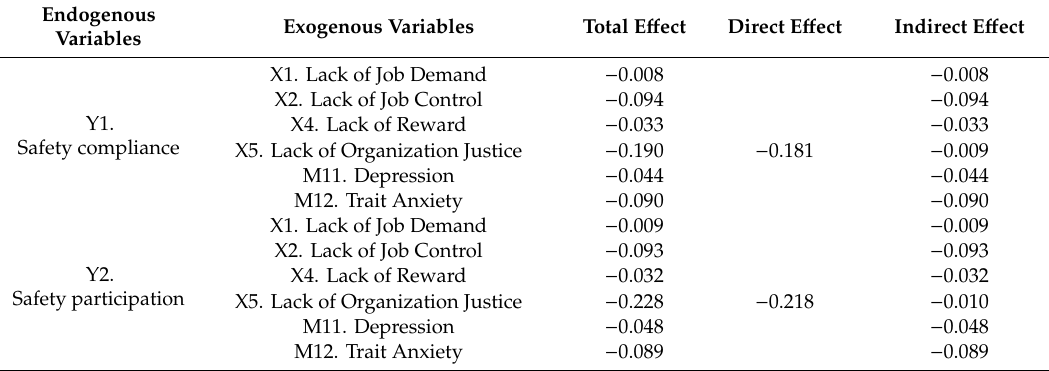
Table 9. Standardized direct, indirect, and total e ff ect in the final